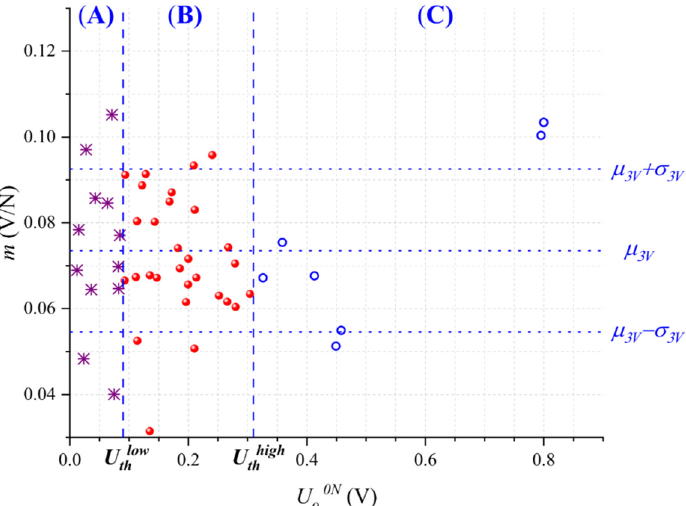
Figure 7. Sensitivity ( m ) as a function of the output voltage at null force ( U o0N ) for each specimen after compensation. Compensation was performed for the sensors belonging to Regions (A) and (C) using different input voltages ( U A , U C ). For comparison purposes, the y-axis scale was held unchanged from Figure 5. Different markers were used for the sensors of Regions (A) and (C) after compensation.